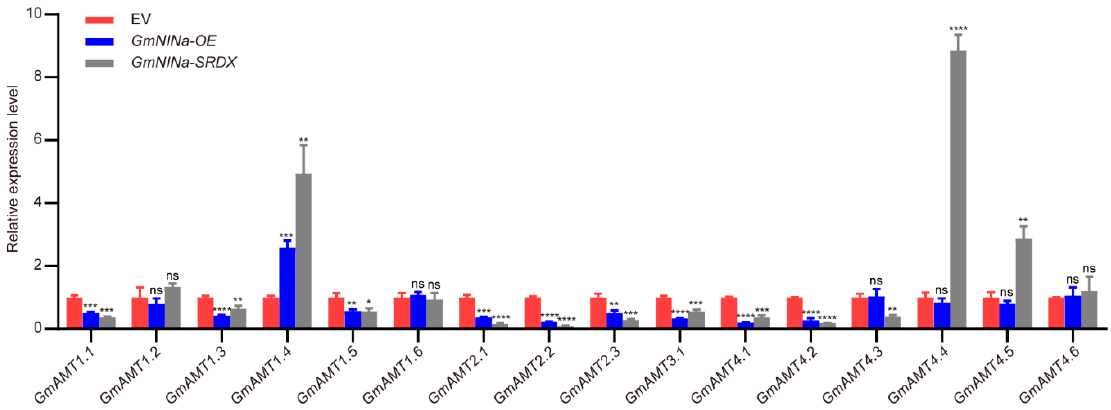
Figure 11. Effect of GmNINa on the expression levels of GmAMT genes. Detection of GmAMTs expression was done by RT-qPCR in hairy roots with empty vector (EV), 35S:GmNINa ( GmNINa-OE ) or 35S:GmNINa-SRDX ( GmNINa-SRDX ) at 3 days after rhizobial inoculation. The normalization was performed using GmELF1b . The statistically significant differences between groups were analyzed using student’s t -test (*, p < 0.05; **, p < 0.01; ***, p < 0.001; ****, p < 0.0001; ns, No